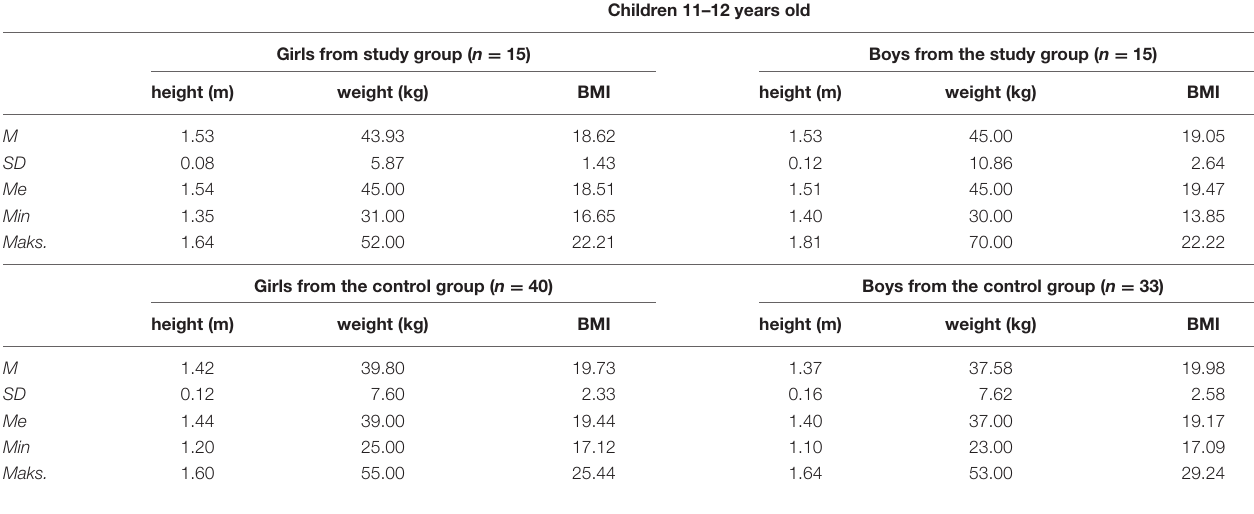
TABLE 3 | Anthropometric indicators among 11–12-year-old children depending on the occurrence of chest pain and